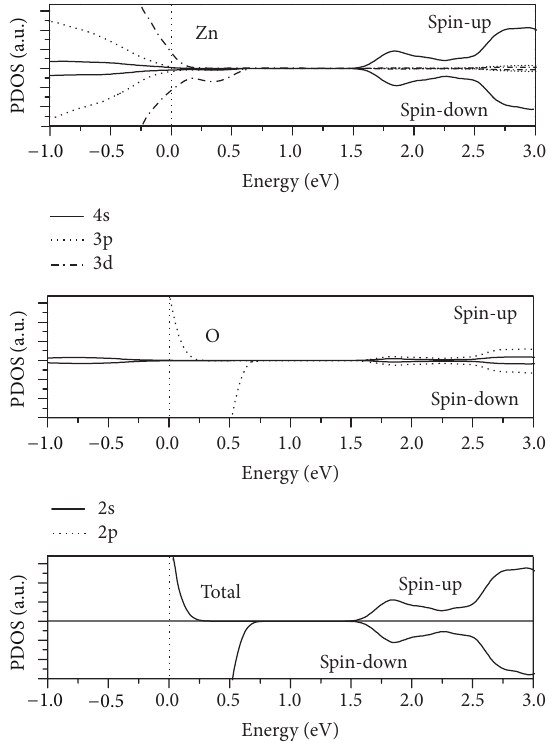
Figure 6: Calculated PDOS of ZnO nanowire with V Zn defect.